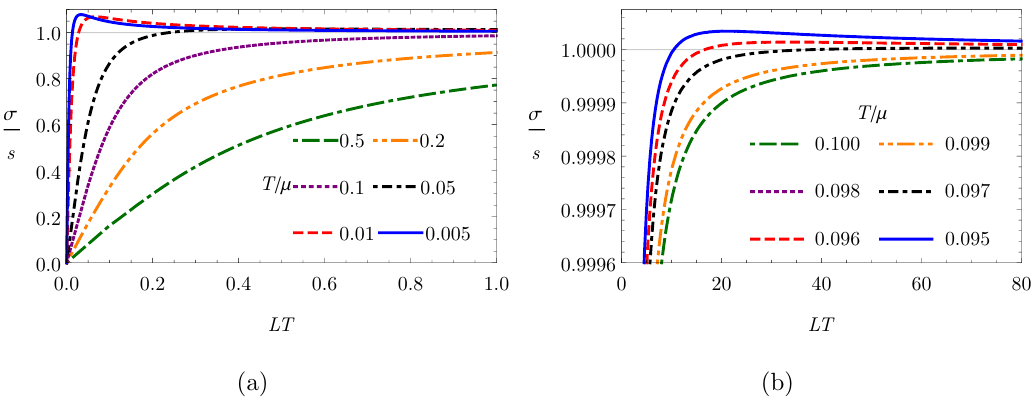
Figure 10. (a) The ED, (cid:27) , in units of entropy density s , versus LT for the sphere in AdS-RN with d = 4, showing the formation of a global maximum as T=(cid:22) decreases from T=(cid:22) = 0 : 5 down to 0 : 005. (b) Close-up of (a) for T=(cid:22) = 0 : 1 down to 0 : 095, including the critical value T=(cid:22) (cid:25) 0 : 097 where the maximum forms.